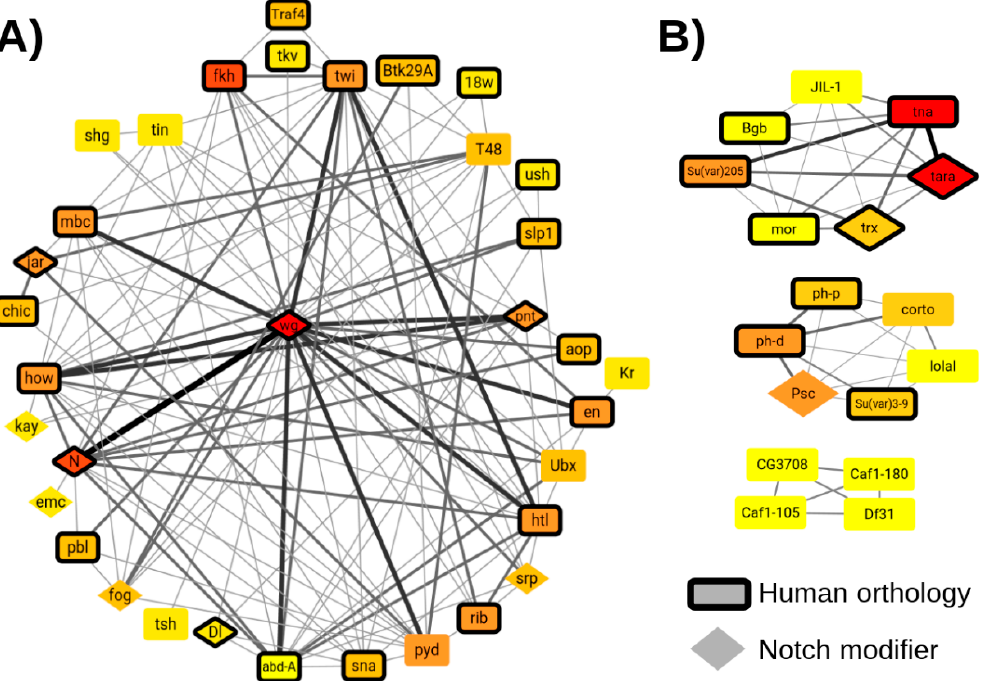
Figure 4. Clusters of developmental regulation and chromatin organisation genes identified by NetNC in multiple TF_ALL datasets. These clusters visualise the combined NetNC-FTI results across the nine TF_ALL datasets; node fill colour, edge width and edge colour indicate frequency of occurrence. Notch modifiers (diamonds) were reported in at least two screens and genes with InParanoid human orthology are shown with black borders. NetNC-FTI clusters for the individual TF_ALL datasets are shown in Figure S4 and are available in Cytoscape format (Data File S1). ( A ) Developmental regulation cluster genes in at least five (yellow), up to nine (red) datasets. Edges shown were in ≥ 5/9 datasets, up to a maximum of 8/9 for N and wg . Thirteen genes (DRC_13) were present in ≥ 7/9 datasets, including wg (9/9) which had highest degree, N (8/9) and fkh (8/9). ( B ) Genes in chromatin organisation clusters from two (yellow) up to six (red) TF_ALL datasets. The three clusters were associated with trithorax-group (top), polycomb group (middle), and chromatin assembly factors (bottom). These results predict components regulated by Snail and Twist in establishing the chromatin blueprint for mesodermal lineages.